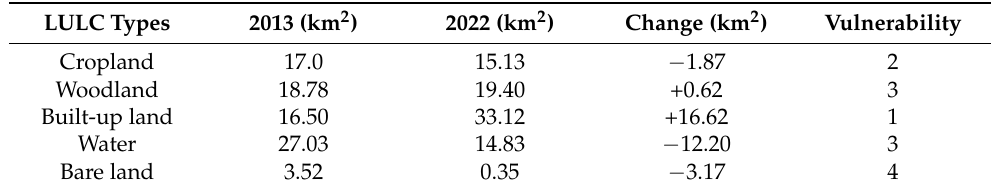
Table 5. Results of LULC classification.